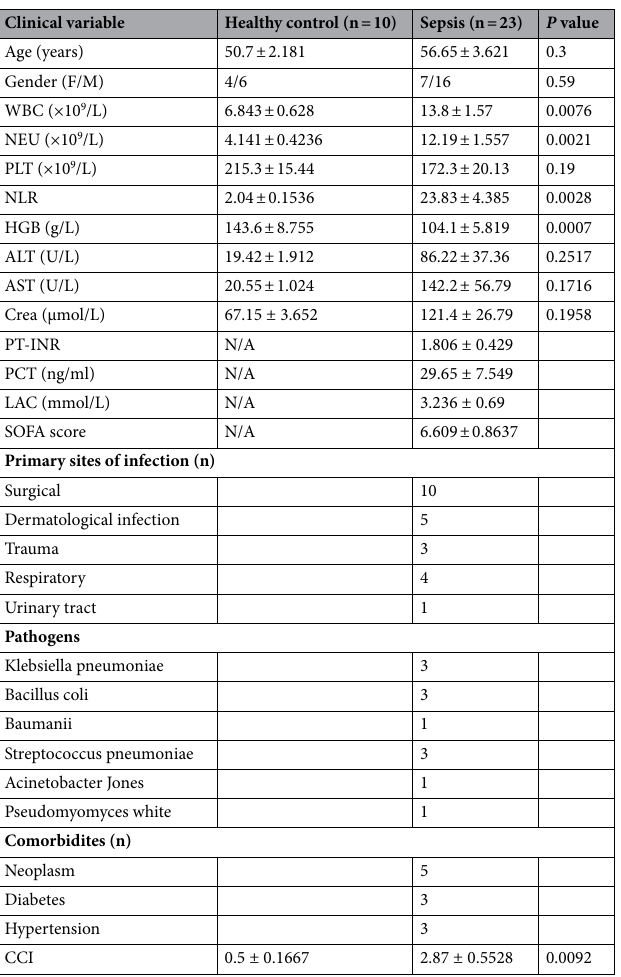
Table 1. Clinical information of the subjects. SOFA score Sequential Organ Failure Assessment score, WBC white blood count, NEU neutrophile, PCT procalcitonin, PLT platelet, NLR neutrophile/lymphocyte ratio, HGB